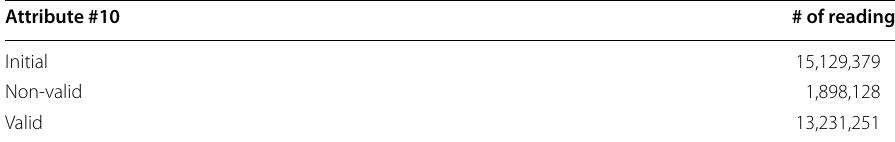
Table 3 Readings: valid/non-valid (attribute #10) Attribute #10